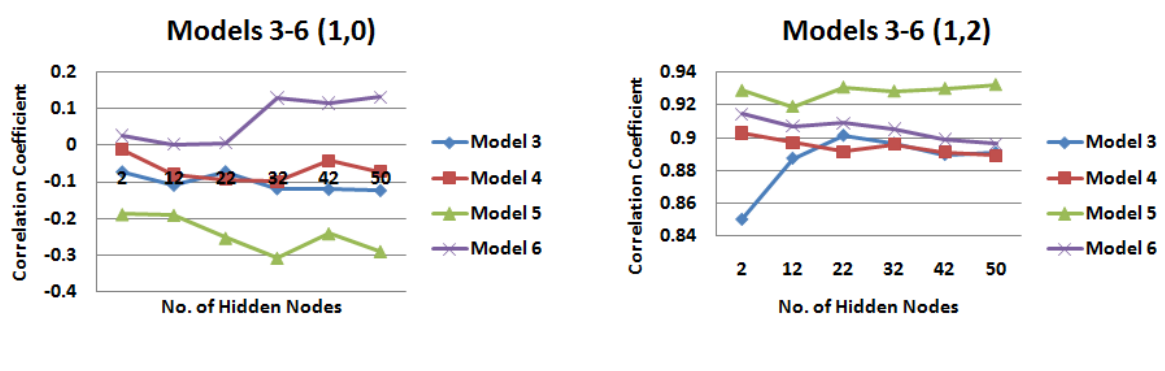
Figure 12. Correlation coefficients for input models 3–6 for 1 day of rainfall information and 0 and 2 days water level information— ( a ) Models 1 and 2 (1,0) ( b ) Models 1 and 2 (1,2) .